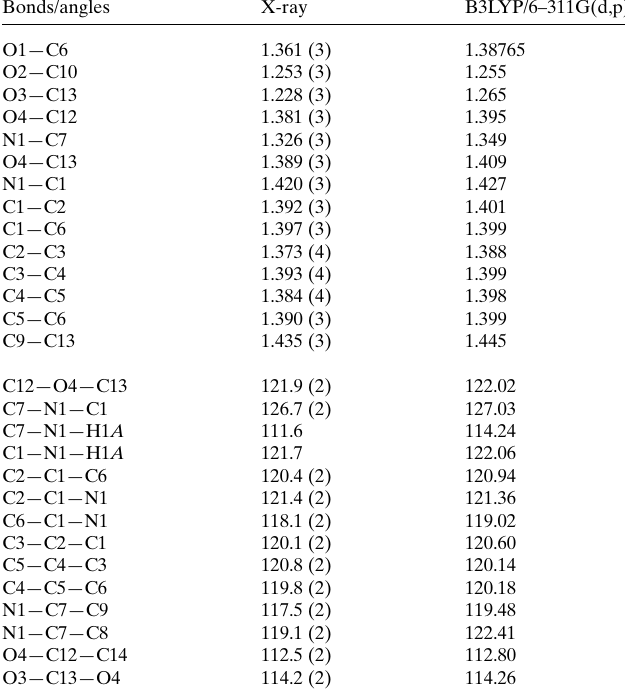
Table 2 Comparison of selected (X-ray and DFT) geometric data (A˚ , (cid:4)